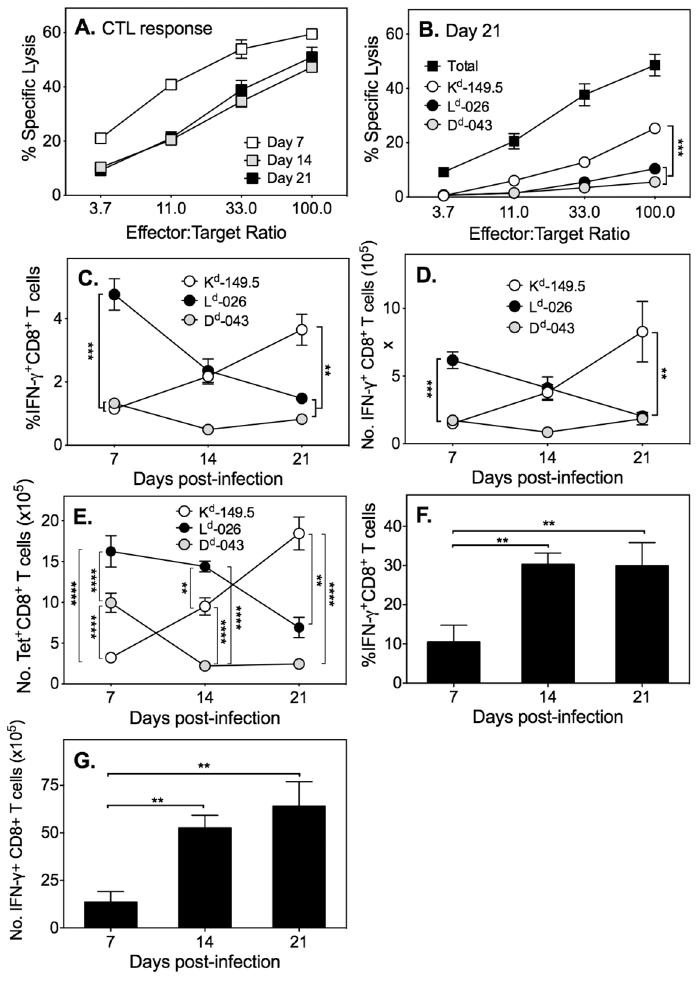
Fig 3. Antigen-specific CD8 T-cell responses at days 14 and 21 p.i. Groups of 5 female BALB/c mice were infected with 500 PFU of ECTV-IFN- γ bp Δ and their spleen cells used to measure CD8 T cell responses. (A) Ex vivo cytolytic activity of splenocytes from ECTV-IFN- γ bp Δ infected mice against virus-infected P815 target cells on days indicated p.i. (B) Ex vivo cytolytic activity of splenocytes obtained from ECTV-IFN- γ bp Δ infected mice 21 days p.i. against ECTV-infected (Total) or ECTV peptide determinant-pulsed P815 target cells. *** , P < 0.001. (C) Percent of ECTV peptide determinant-specific IFN- γ + CD8 T cells. ** , P < 0.01 and *** , P < 0.001. (D) Numbers of ECTV peptide determinant-specific IFN- γ + CD8 T cells. ** , P < 0.01 and *** , P < 0.001. (E) Numbers of peptide-MHC class I tetramer + CD8 T cells. ** , P < 0.01 and **** , P < 0.0001. (F) Percent ECTV-specific (total) IFN- γ + CD8 T cells. (G) Numbers of ECTV-specific (total) IFN- γ + CD8 T cells. ** , P < 0.01. P values for all panels were obtained by Mann-Whitney U